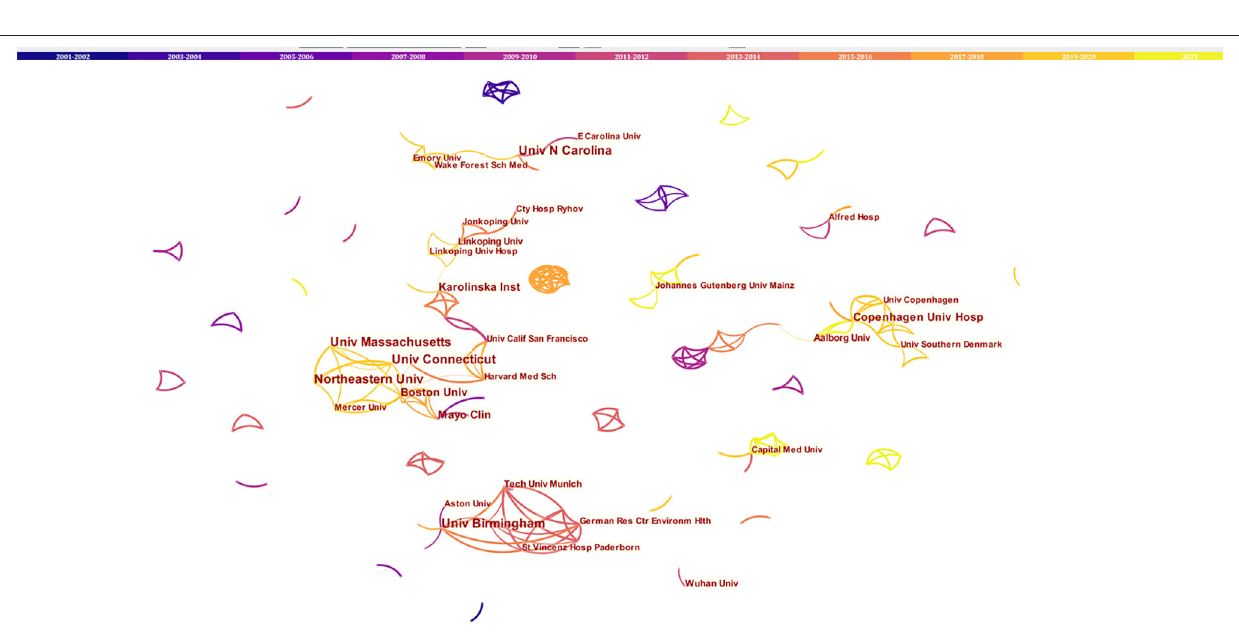
FIGURE 5 | The network of institutions engaged in the research about atrial fibrillation and depression. In the networks, the larger the node was, the more contribution the institution had made to that field. The color of the line represents the time of first co-occurrence. The thicker the line is, the greater the connection strength is (calculation method based on